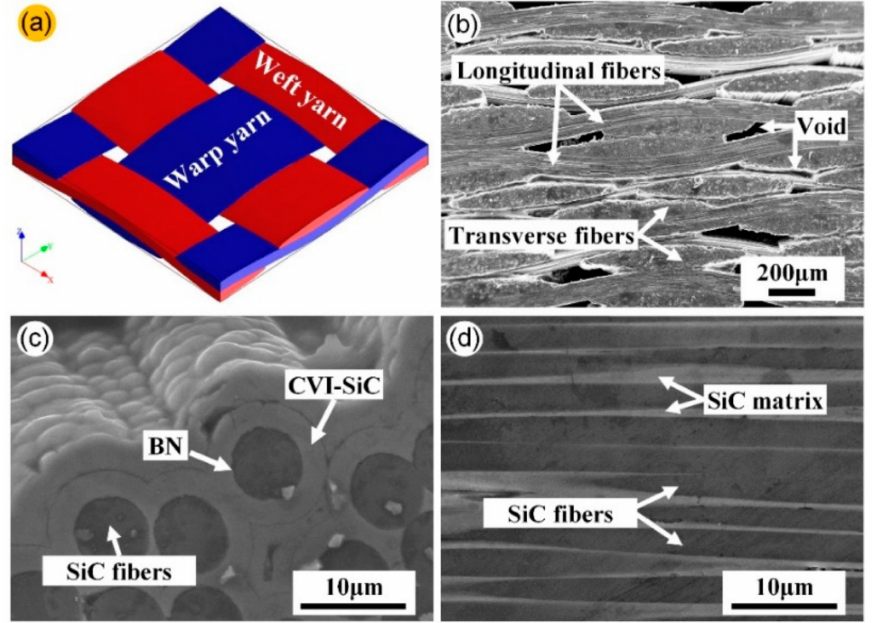
Figure 1. The structure of 2D SiC f /SiC composites: ( a ) model of SiC fiber preform, ( b ) micro- morphology by SEM, ( c ) micro-structure along transverse fibers, ( d ) micro-structure along longitudi- nal